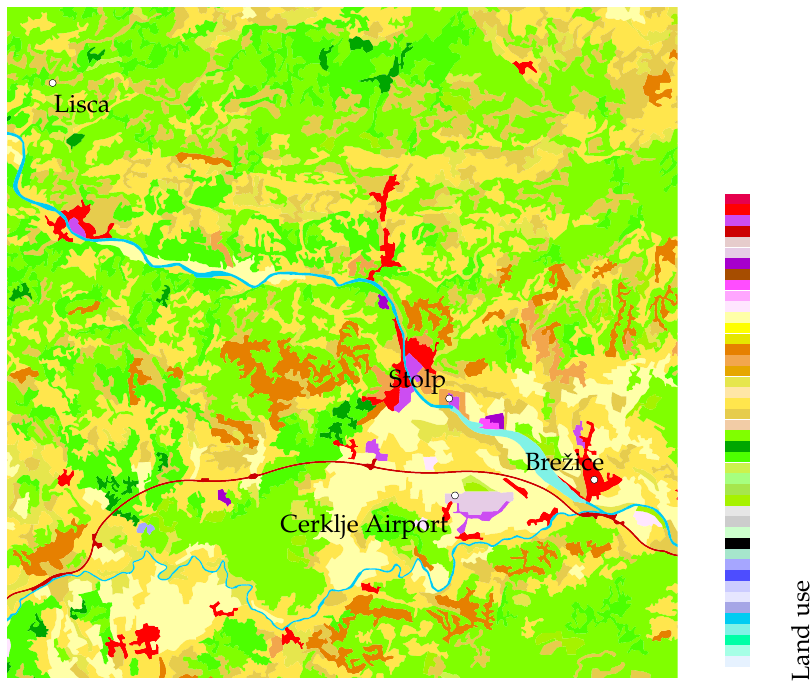
Figure 4. CORINE Land Cover [32] for the study area (30 km by 30 km) with the meteorological stations